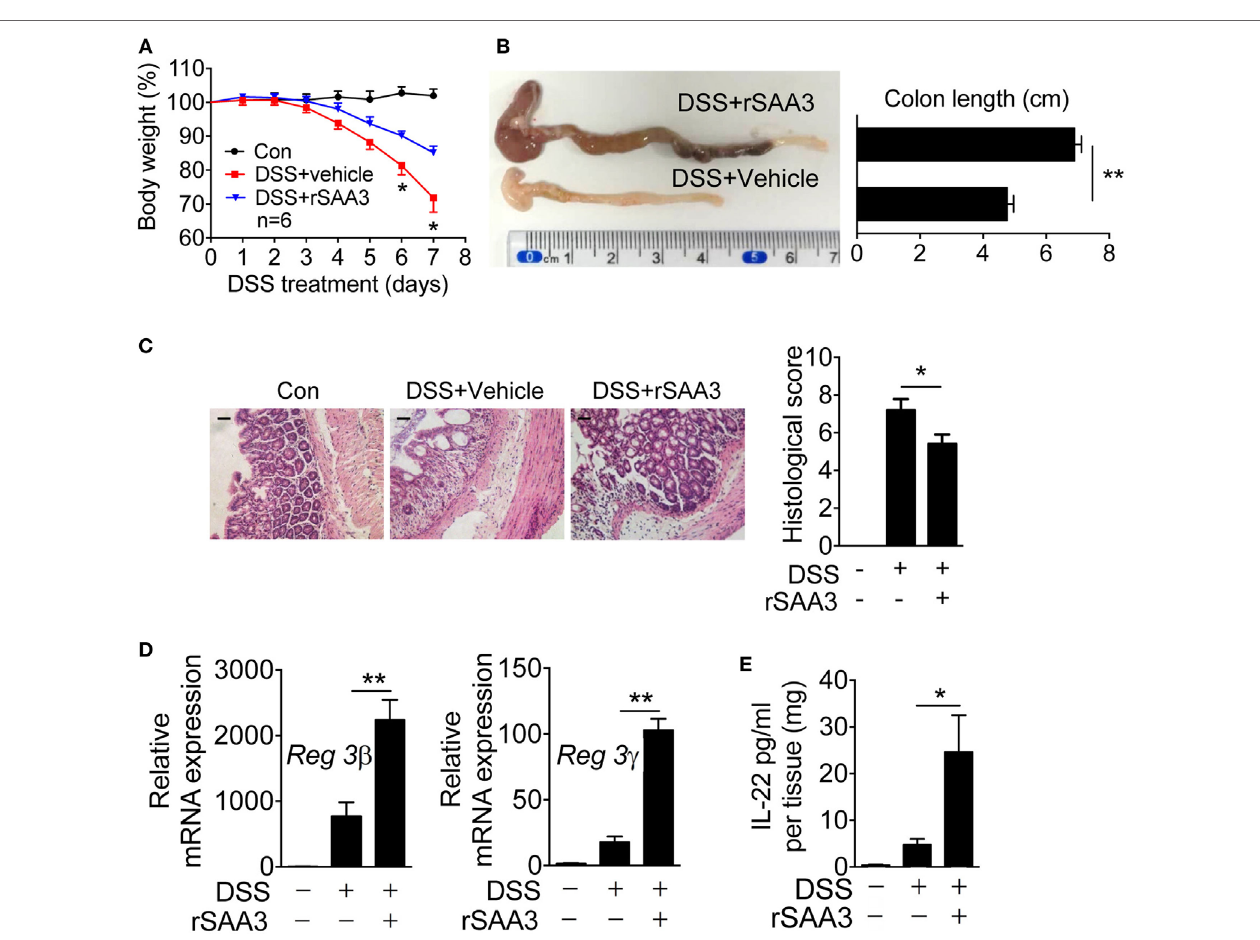
FigUre 4 | Amelioration of dextran sulfate sodium (DSS)-induced colitis by recombinant SAA3 (rSAA3). (a) Weight loss was monitored every day in Saa3 − / − mice receiving DSS with rSAA3 (blue) or without rSAA3 (red) or drinking water only (black). (B) A representative image (left) and quantitative analysis of colon length measurement (right, n = 5). (c) Representative images of paraffin sections of distal colon tissue were stained with hematoxylin and eosin (left panel), and pathology scores were obtained (right panel, n = 5). Scale bars, 20 micrometers. (D) Relative mRNA levels of Reg3 β (left) and Reg3 γ (right) in Saa3 − / − colitis mice receiving water or DSS with or without rSAA3 were quantitatively analyzed ( n = 5). (e) Colonic tissue explants ( n = 5 each, receiving water, DSS, and DSS + rSAA3) were collected 7 days after treatment and then cultured ex vivo for 24 h for measurement of secreted IL-22 by ELISA. Male and female mice 8–10 weeks of age were used in the above experiments. For all quantitative data above, * p < 0.05 and ** p < 0.01 between different